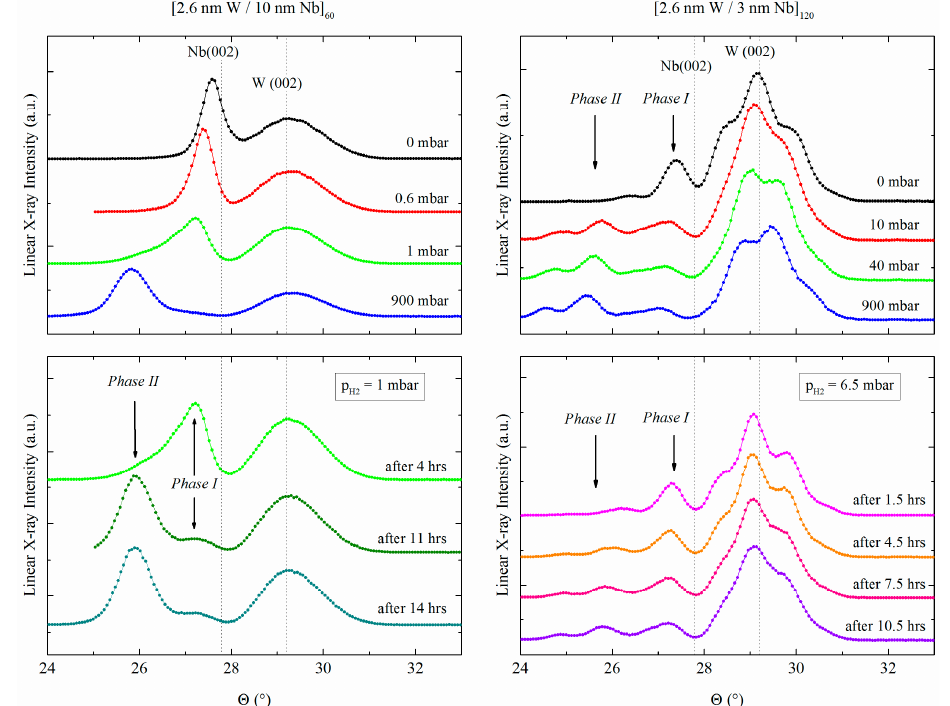
Figure 11. Cu K α X ‐ ray diffraction on the multilayers [2.6 nm W/10 nm Nb] 60 ( left ); and [2.6 nm W/3 nm Nb] 120 ( right ) as a function of increasing external hydrogen pressure, and ( bottom ) time ‐ resolved measurement at 1 mbar and 6.5 mbar, respectively. The dashed lines indicate the positions of the Nb(002) and W(002) bulk reflections.